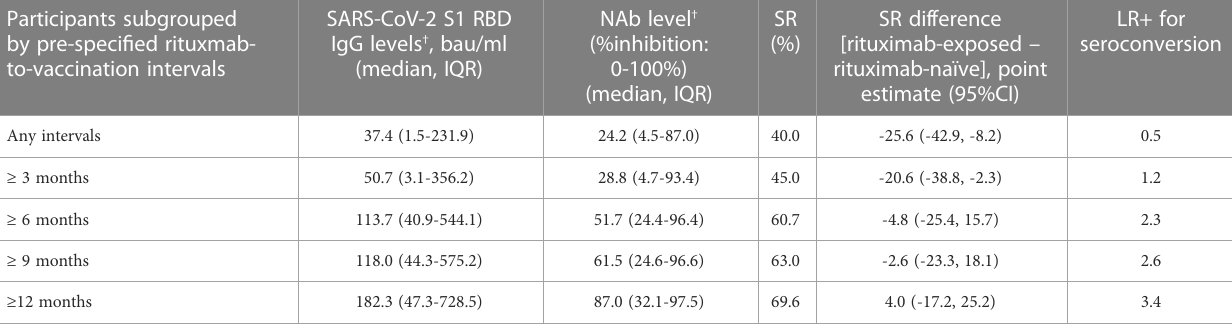
TABLE 2 SARS-CoV-2-speci fi c humoral immunity levels achieved by rituximab users with different ranges of rituximab-to-vaccination intervals. Participants subgrouped by pre-speci fi ed rituxmab- to-vaccination